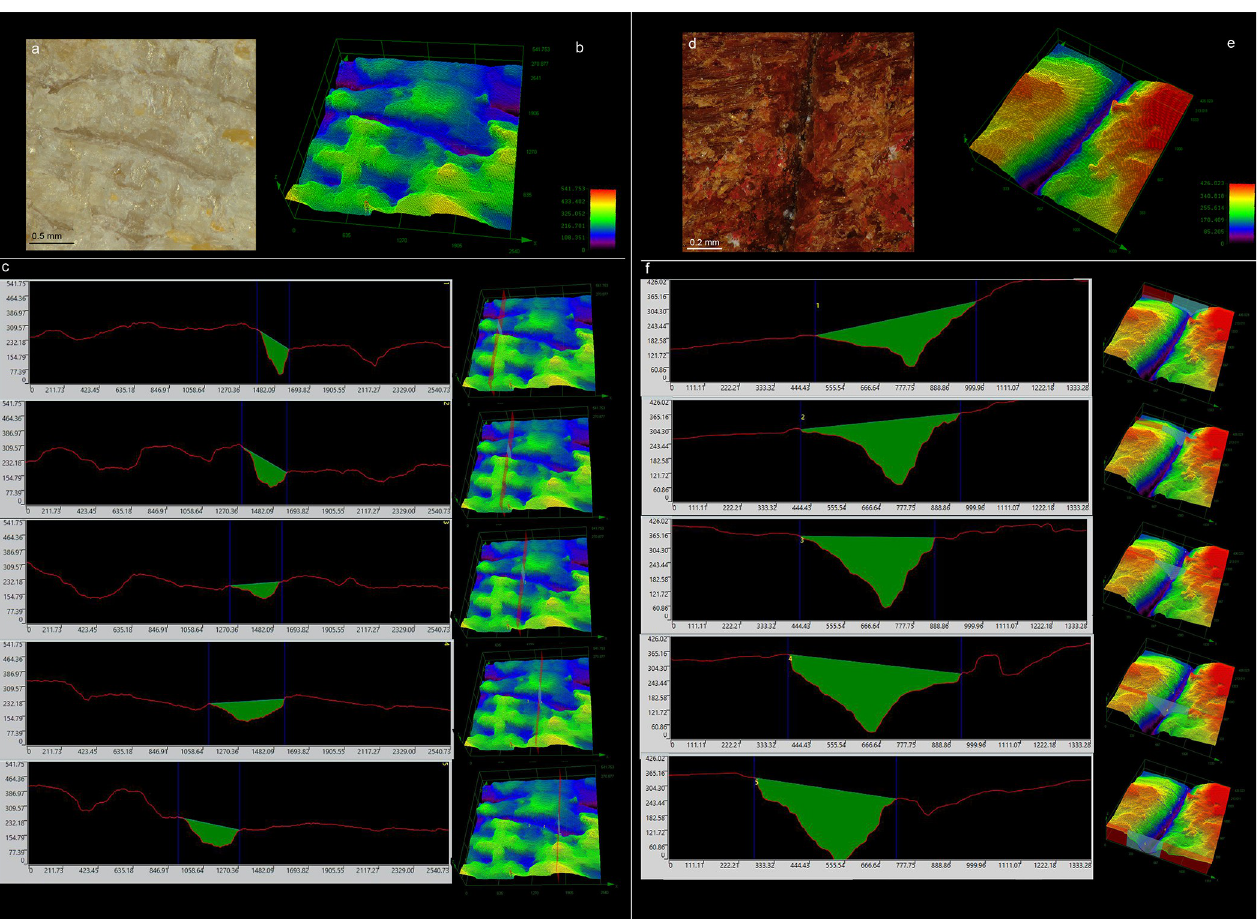
Fig 6. 3D analysis of a single linear impression on bone retoucher (left) and boomerang (right). (a) colour 2D image of a linear impression on bone retouchers (10x); (b) image of the same stigma with 3D height data; (c) V-shaped profile measurements and cross-section internal surface measured in different portions of the linear impression on bone retoucher; the deep penetration of the use mark in the bone surface can be observed. (d) colour 2D image of a linear impression on boomerang (10x); (e) image of the same stigma with 3D height data; (f) V-shaped profile measurements and cross-section internal surface measured in different portions of the linear impression on boomerang; the deep penetration of the use mark in the wooden surface can be observed.